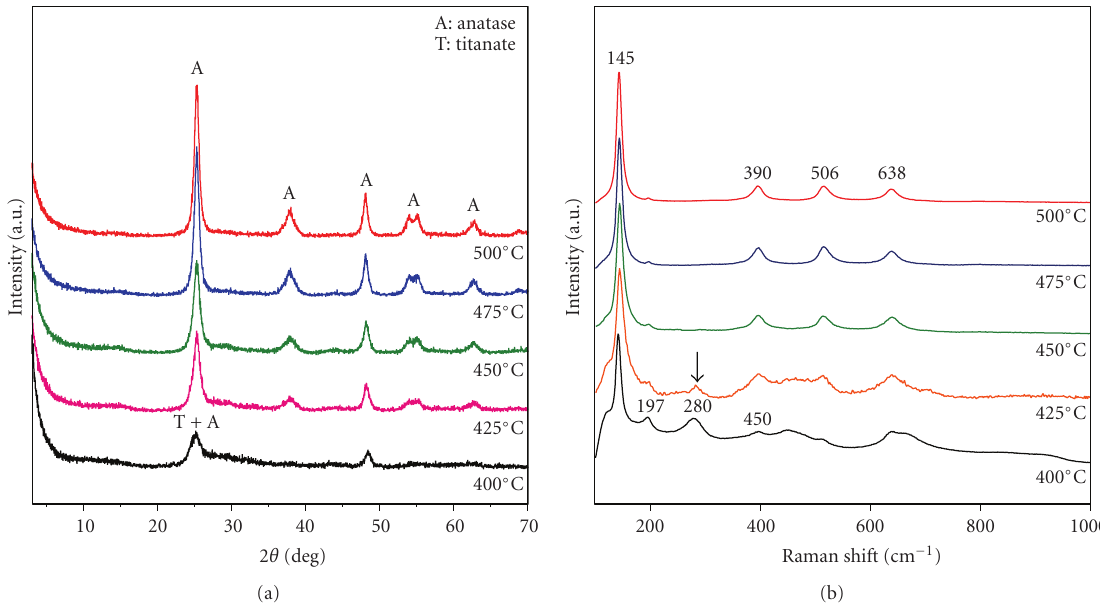
Figure 1: X-ray di ff raction patterns (a) and Raman spectra (b) of the calcined powders with di ff erent temperatures in O 2 atmosphere for